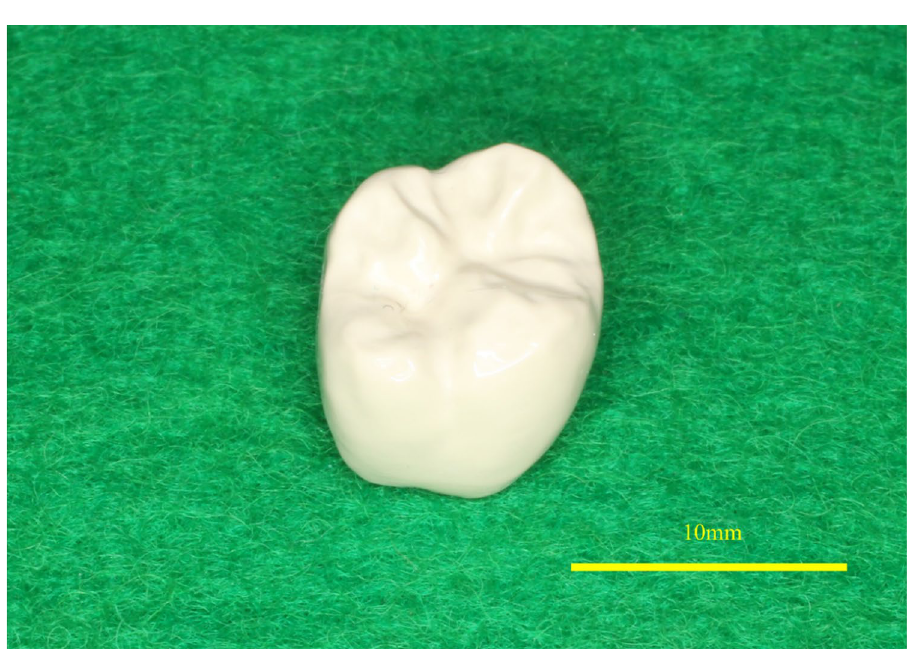
Figure 2. View of the occlusal surface of the completed polyetheretherketone crown. The crown designed by CAD in Fig. 1 was cut from a PEEK block using a milling machine and polished to a high gloss